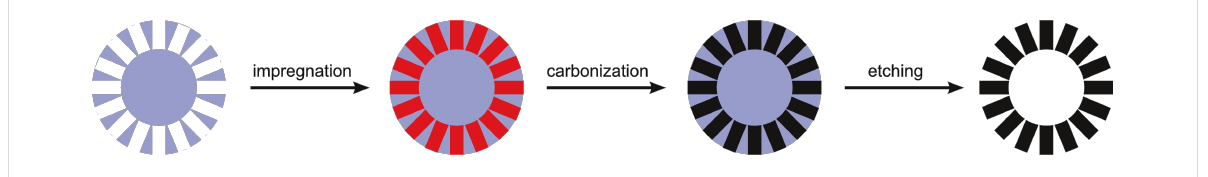
Figure 1: Synthesis of the hollow carbon spheres via impregnation of silica spheres with solid core and mesoporous shell, followed by carbonization and etching of silica.